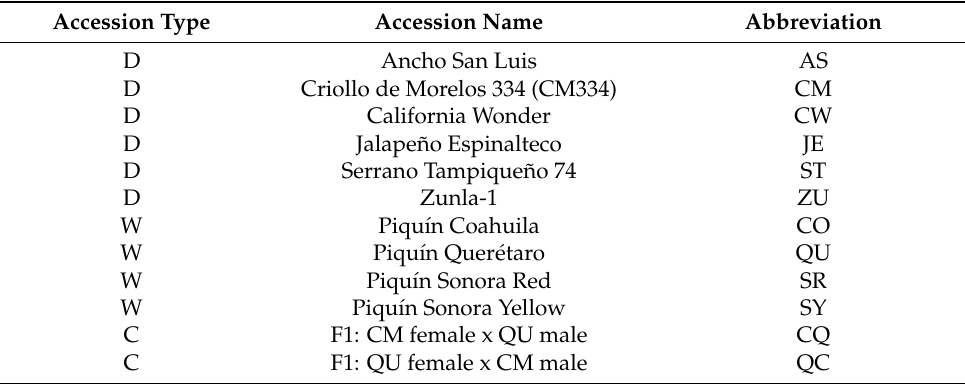
Table 1. Chili pepper accessions used for the RNA-Seq